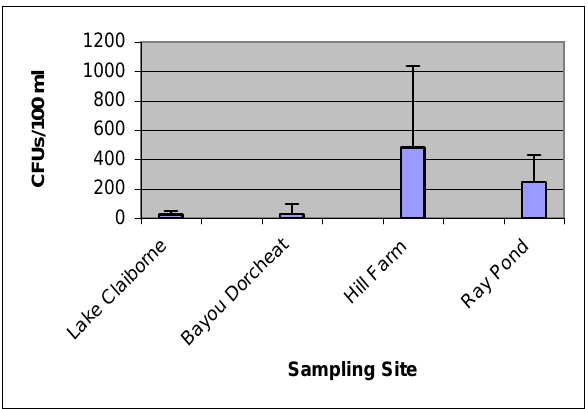
Figure 11: Mean values of E. coli colonies/100 ml for each sampling